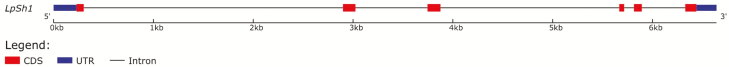
Gene structure of LpSH1.